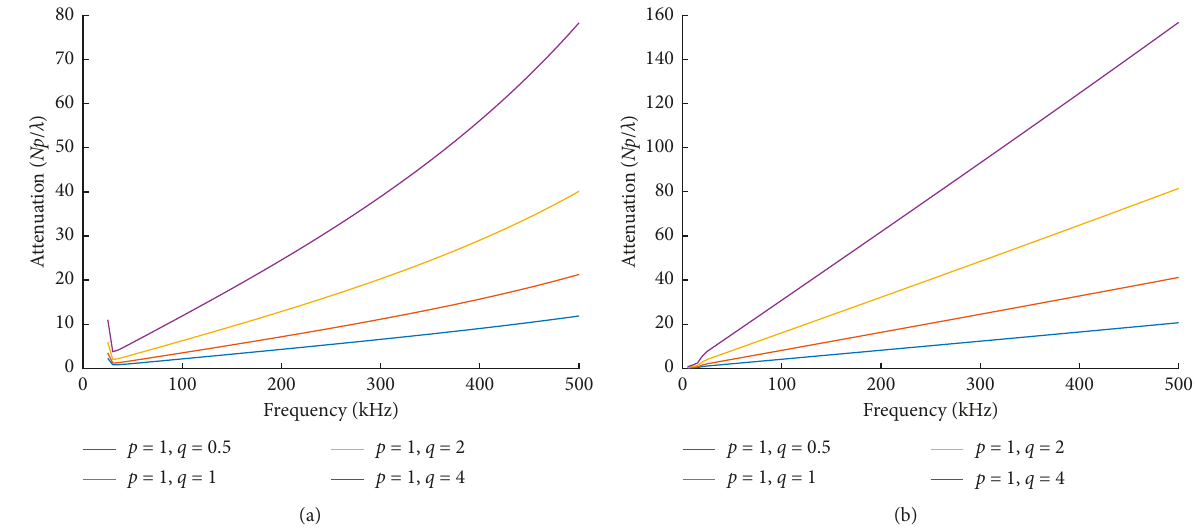
Figure 6: Attenuation dispersion curves of guided wave, q � 0.5, 1, 2, and 4. (a) Attenuation curves of L ( 0 , 2 ) . (b) Attenuation curves of T ( 0 , 1 ) .